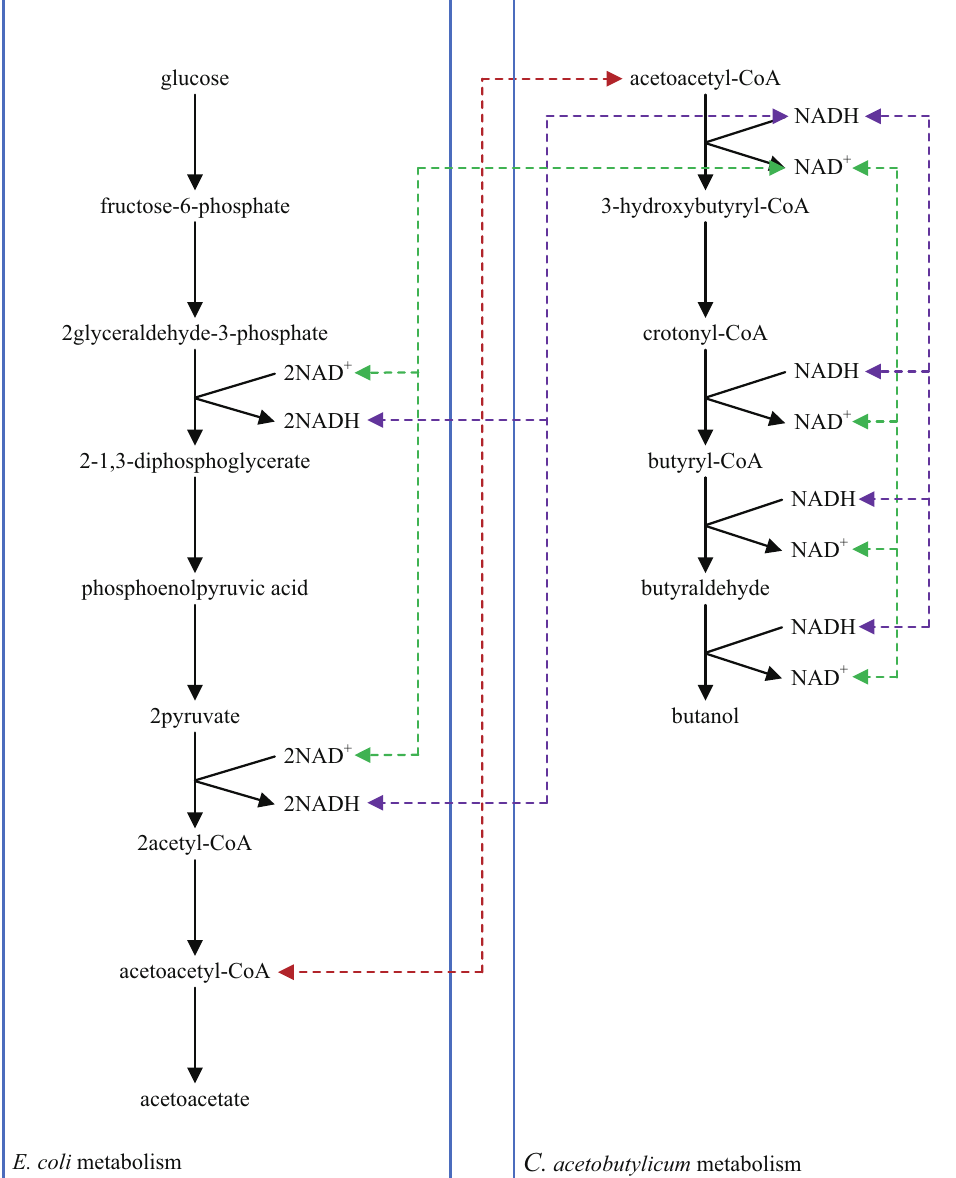
Figure 8. Metabolic pathways of synthetic butanol production using synthetic biology techniques. Acetoacetyl-CoA, NAD + , and NADH with unique stoichiometric coefficients appear in both Escherichia coli and Clostridium acetobutylicum metabolisms. Dashed lines indicate the connection of these two different metabolisms through these